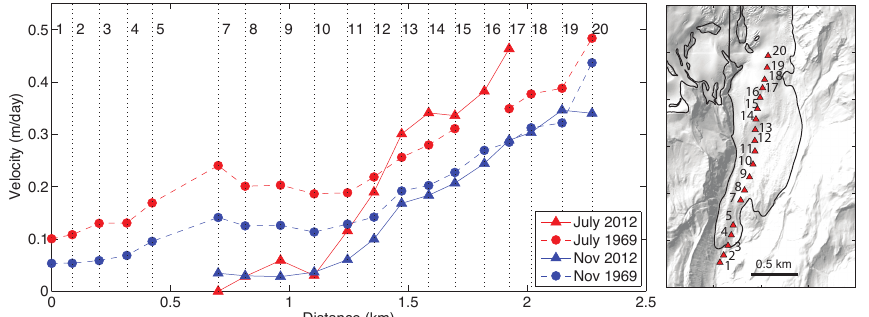
Figure 11. July and November 1969 surface velocities measured by Hodge (1974; digitized from Hodge, 1972) at 19 stake locations along lower Nisqually profile (circles), compared with sampled 2012 slope-parallel velocities for corresponding locations/seasons (triangles). Stake locations are labeled and indicated with dotted lines and are shown in map view at right (same map extent as Fig.